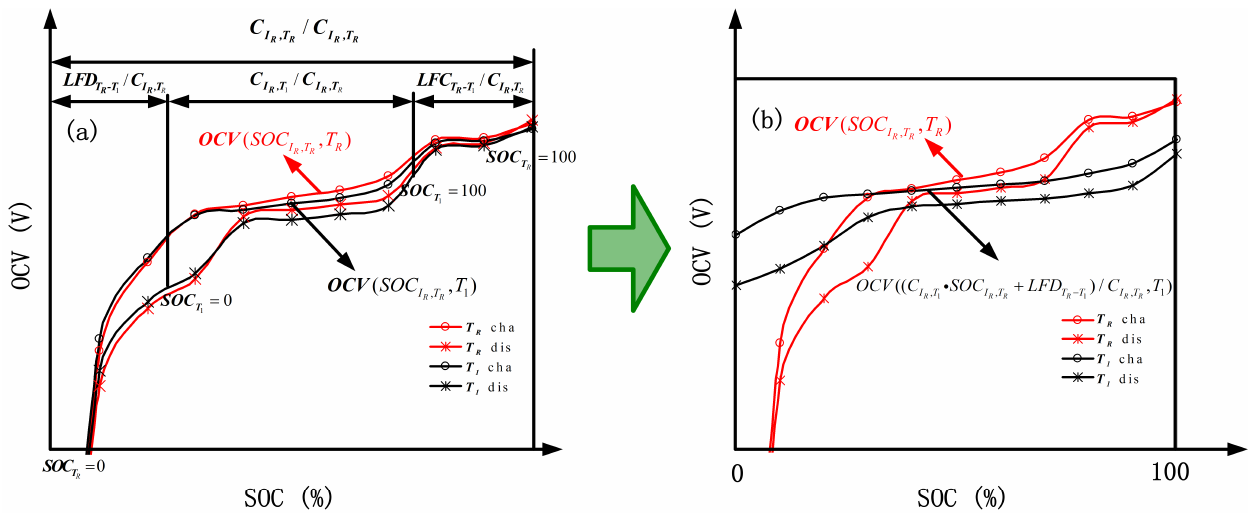
Figure 13. Process of conversion from the rated OCV–SOCs to the R–L non-rated OCV–SOCs.